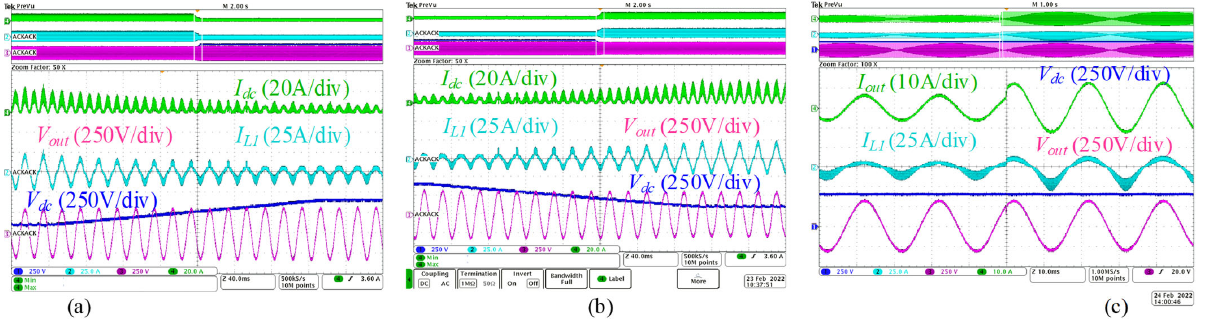
Figure 13. Experimental results in reactive power modes: at input voltage of 200 V and output apparent power of 1 kVA; ( a ) with power factor of 0.7 leading, ( b ) with power factor of 0.96 lagging, and ( c ) voltage stress of the switches S 1 , S 2 , and S 3 .